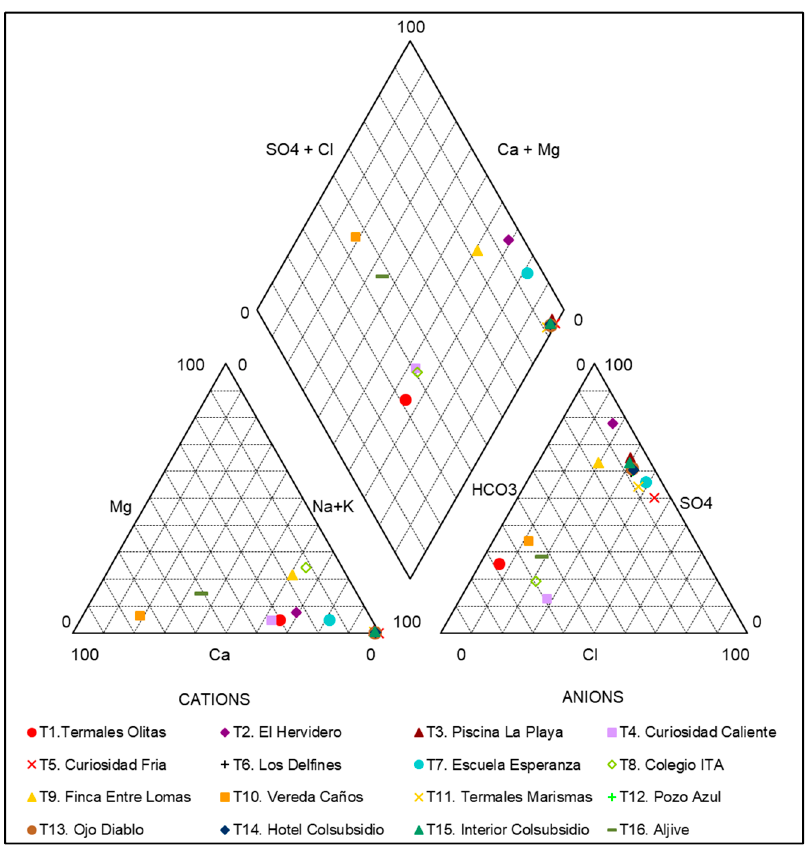
Figure 8. ( a ) Map of Fe content in the Paipa area and the relationship of Fe concentration vs. temperature in the left corner. ( b ) Map of electrical conductivity in this area. In both plots, a color and size scale are used: reddish-warm colors and big dots are related to high values.